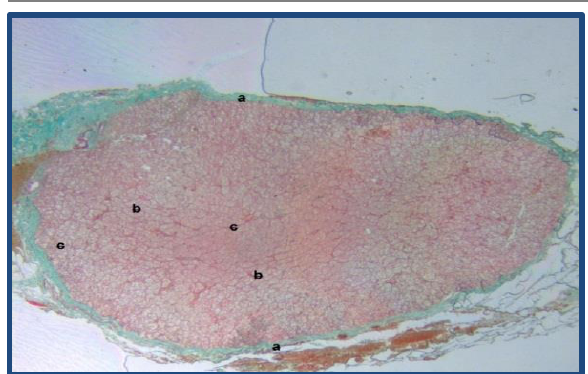
Figure, 8: Parathyroid gland shows: a- Capsule. b- cords of chief cells c- thin septa (Masson trichrome stain, 40 X).